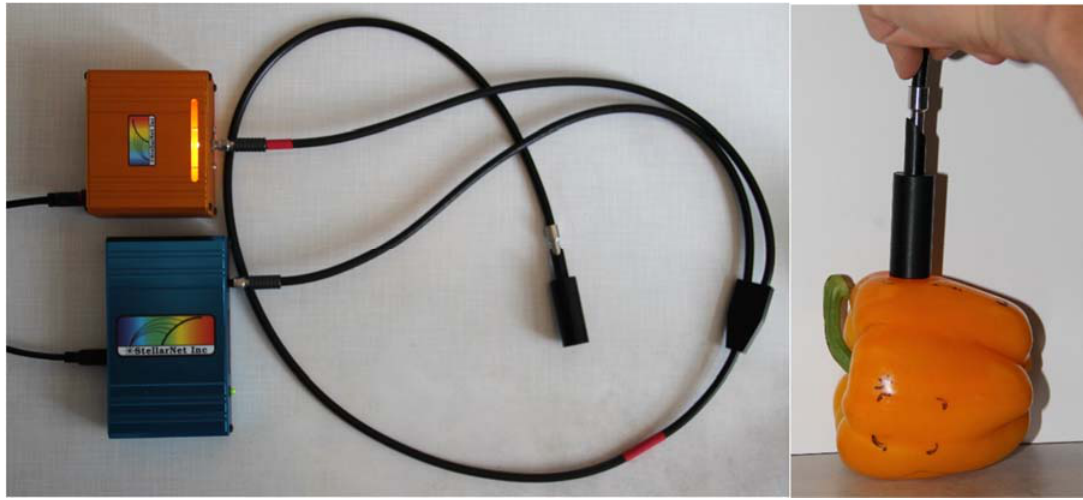
Figure 3. Light reflectance measurements (0° from the normal) with a portable spectrometer.